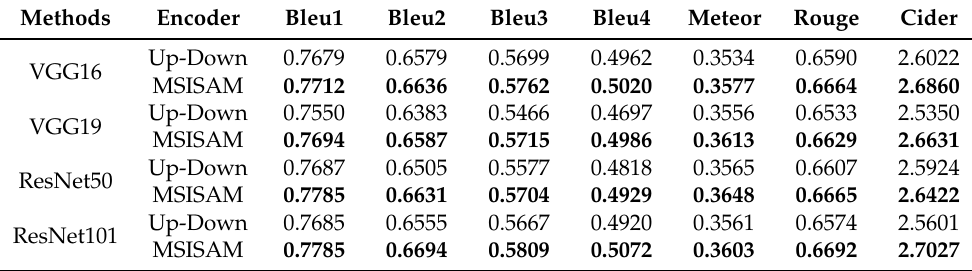
Table 9. Comparison experiments on the RSICD data set [3] based on different